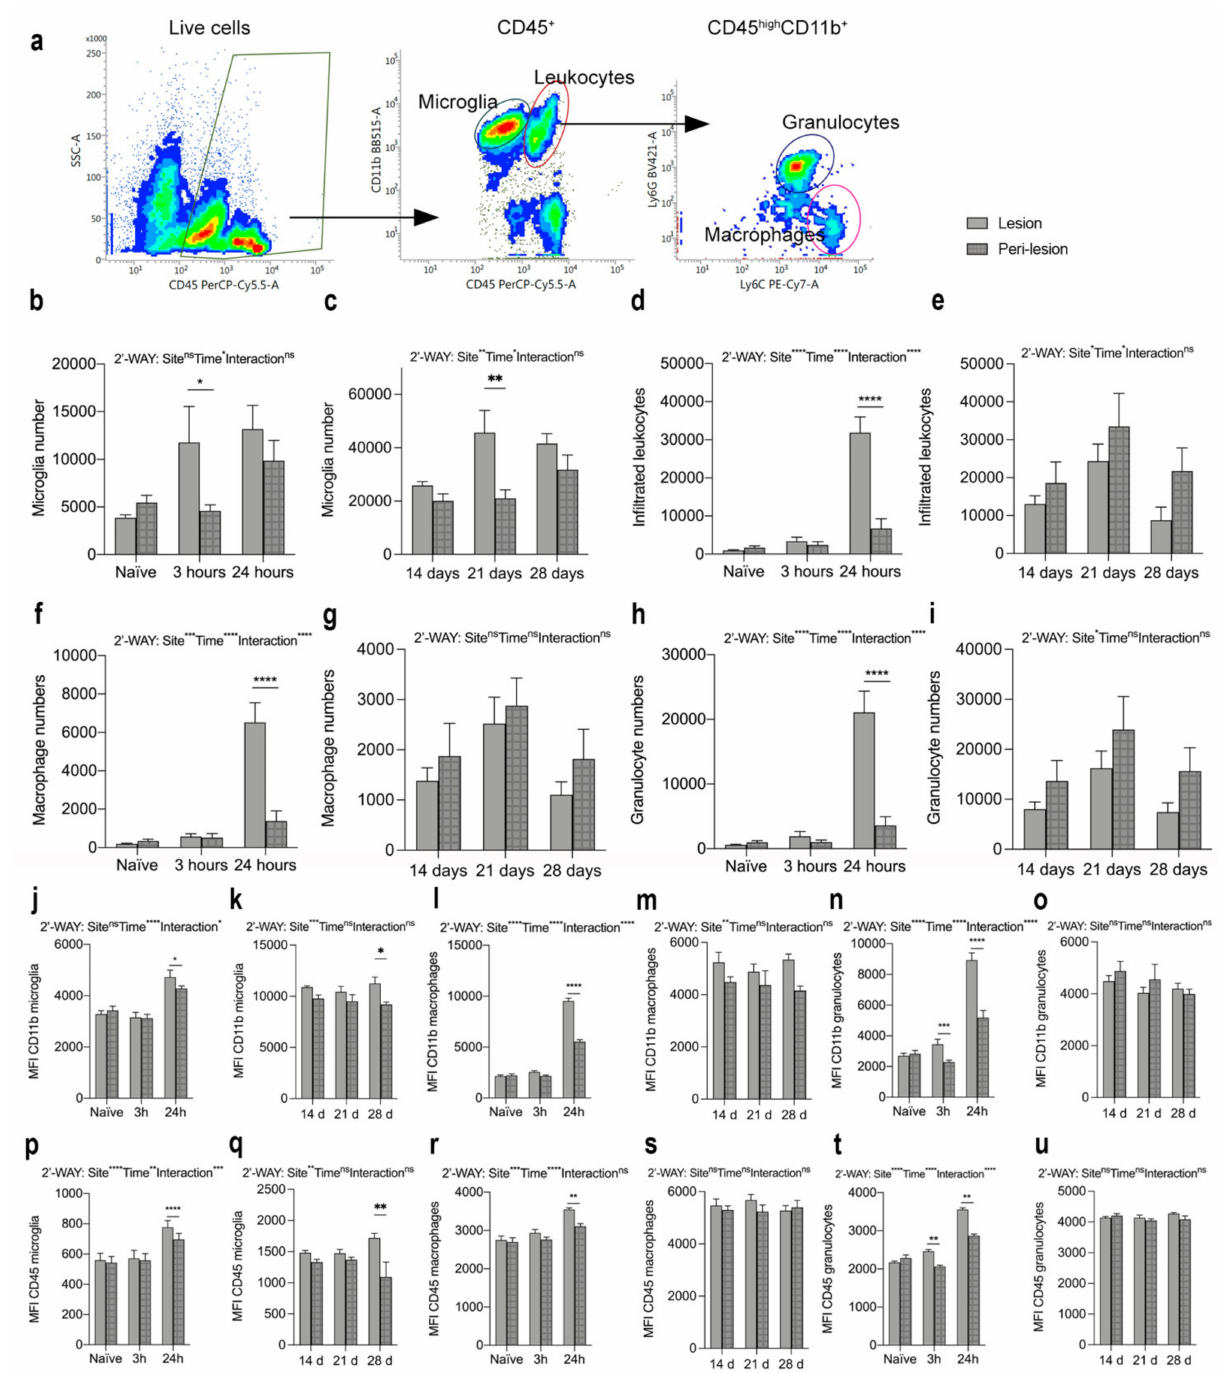
Figure 6. Changes in microglia and leukocyte populations after SCI. ( a ) Representative dot plots show- ing the gating strategy. Only live cells were included. ( b , c ) Number of microglia (CD11b + CD45 dim ) in the acute (( b ), Interaction: F 2,28 =35.16, p < 0.0001; Time: F 2,28 = 18.19, p < 0.0001; Site: F 1,28 = 10.26, p = 0.003) and chronic (( c ), Interaction: F 2,22 = 2.04, p = 0.15; Time: F 2,22 = 4.37, p = 0.03; Site: F 1,22 = 11.14, p = 0.003) phases after SCI. ( d , e ) Number of infiltrating leukocytes (CD11b + CD45 high ) in the acute (( d ), Interaction: F 2,28 = 80.03, p < 0.0001; Time: F 2,28 = 154.9, p < 0.0001; Site: F 1,28 = 32.13, p < 0.0001) and chronic (( e ), Interaction: F 2,22 = 0.24, p = 0.79; Time: F 2,22 = 4.09, p = 0.03; Site: F 1,22 = 4.44, p < 0.05) phases after SCI. ( f , g ) Number of infiltrating Ly6C + Ly6G − macrophages in the acute (( f ), Interaction: F 2,28 = 31.60, p < 0.0001; Time: F 2,28 = 66.72, p < 0.0001; Site: F 1,28 = 17.75, p = 0.0002)